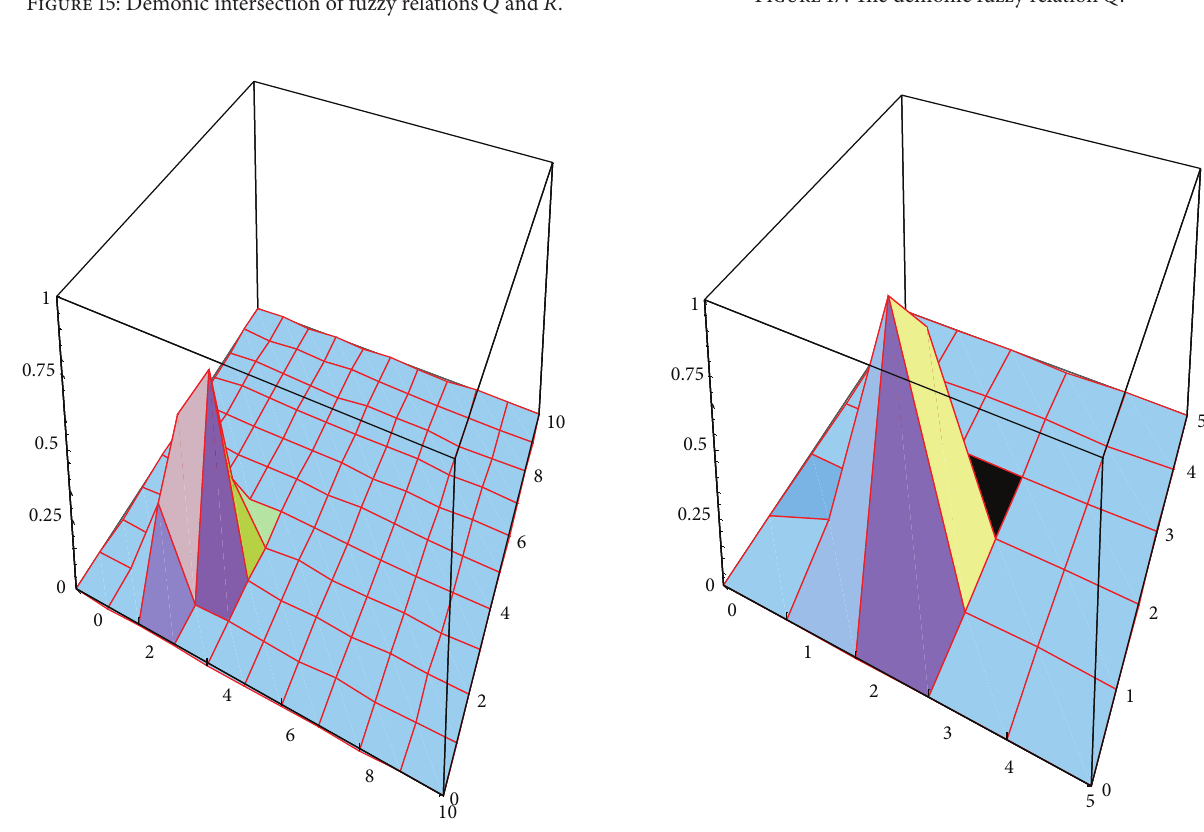
Figure 17: The demonic fuzzy relation